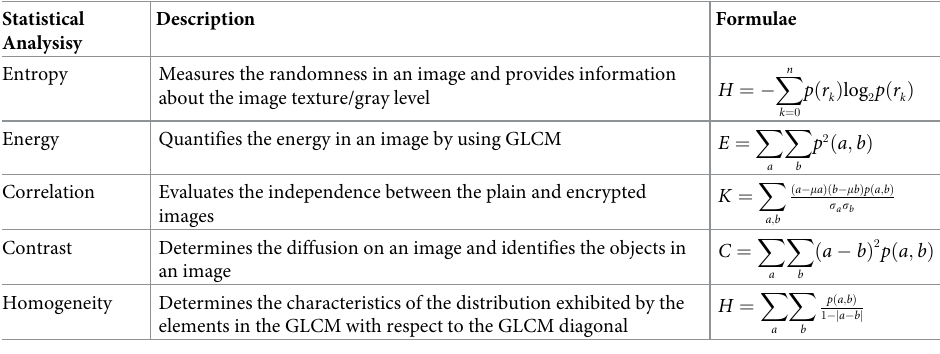
Table 11. Statistical analysis parameters with description and formulae.